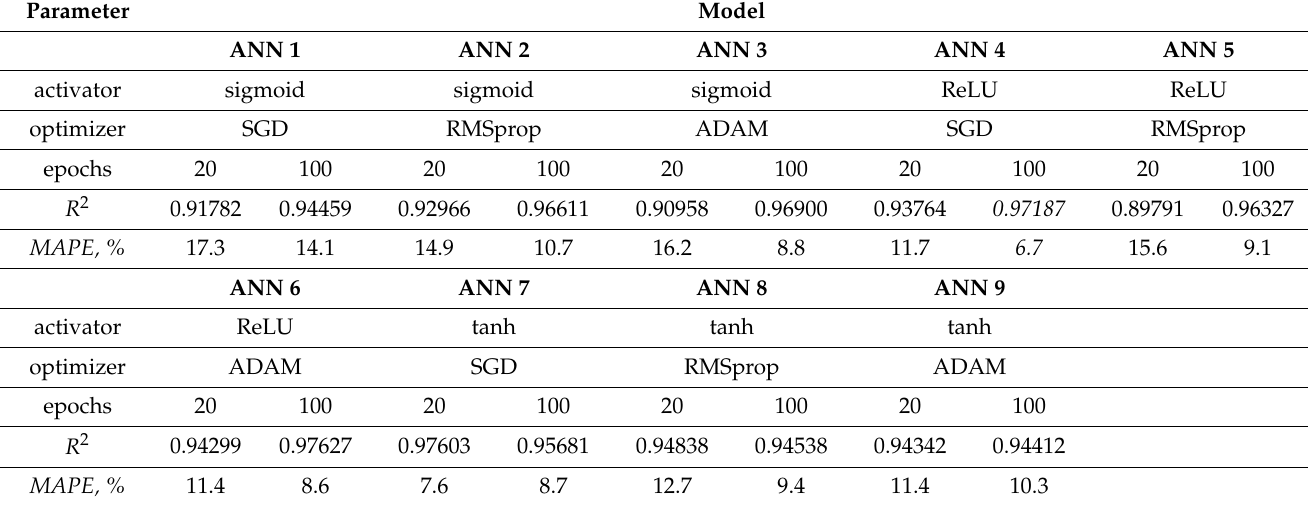
Table 11. The parameters of the ANN